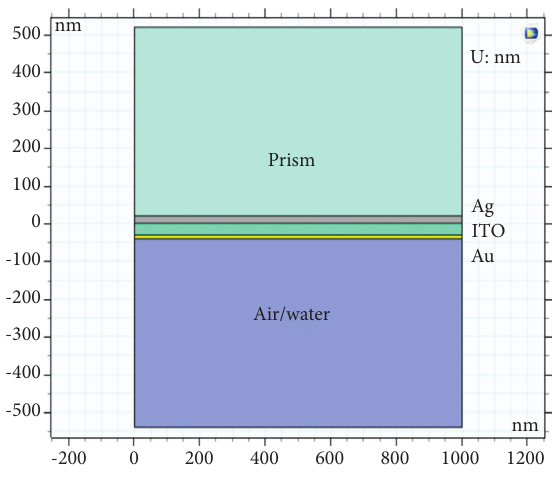
Figure 2: 2D model diagram.